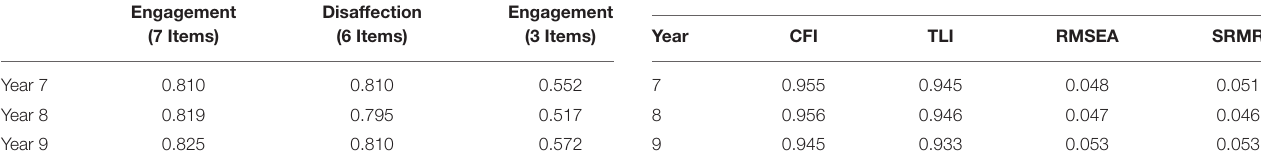
TABLE 3 | CFA model fit indices across all three measurement